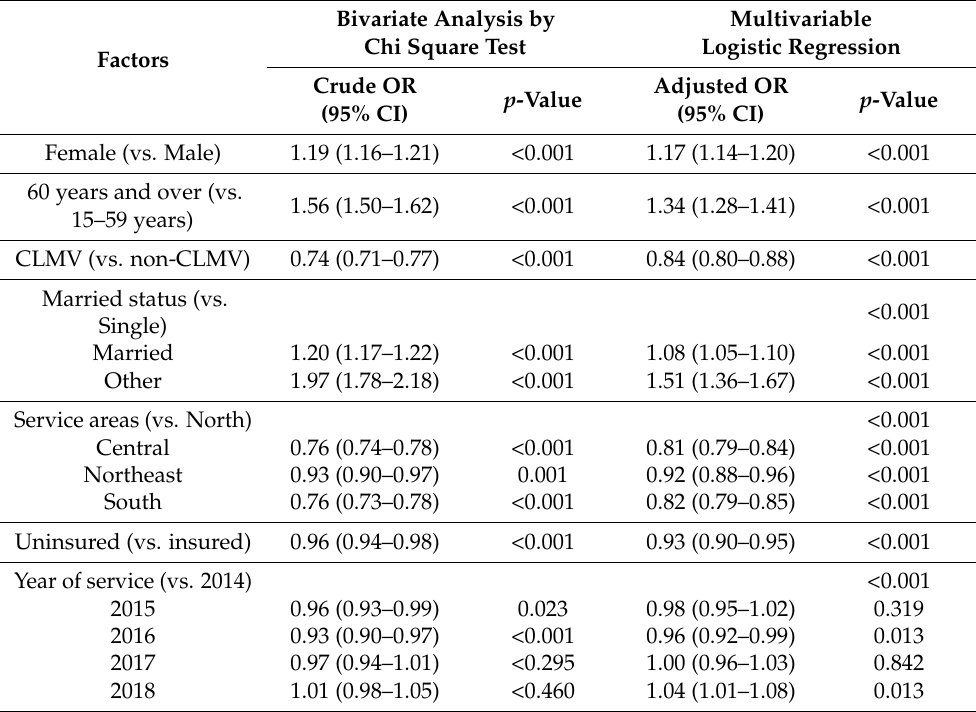
Table 2. Factors associated with NCD OP visits among expatriate patients in Thailand, 2014–2018.